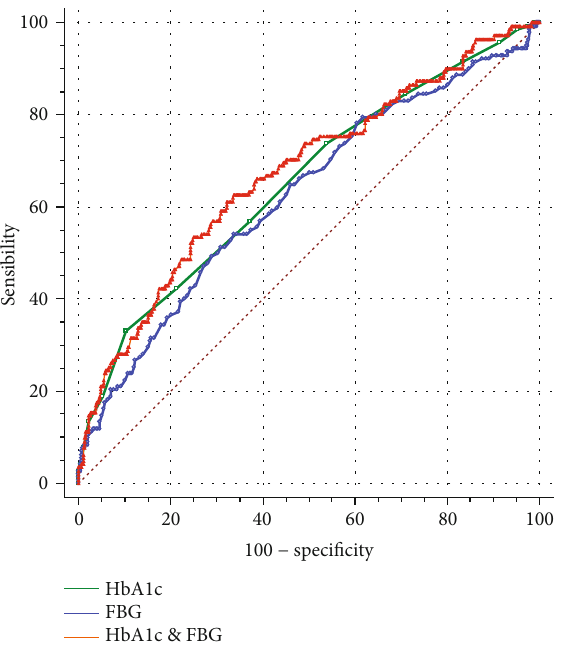
Figure 2: Comparison of the ROC curves of HbA1c, FBG, and the two combined